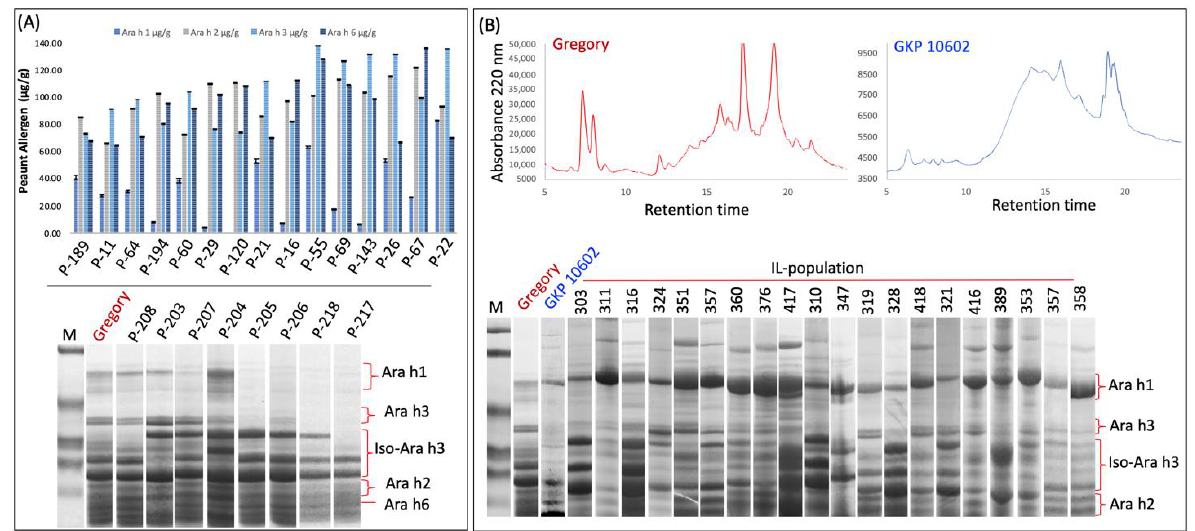
Figure 2. Protein profiles of peanut genotypes with reduced content of immunogenic proteins Ara h1, Ara h2, Ara h3, and Ara h6. Selected genotypes of the USDA and ICRISAT mini-core collections with reduced content of major immunogenic proteins studied using enzyme-linked immunosorbent assay (ELISA) ( A , top ). SDS-PAGE gel showing selected genotypes of the South Asian collection lacking Ara h1, Ara h3, and Ara h6 completely or accumulating a reduced amount of different immunogenic proteins ( A , bottom ). High-performance liquid chromatograms of seed-storage proteins extracted from peanut cultivar ‘Gregory’ and Arachis diogoi accession GKP 10602 (identified from the screen for reduced immunogenicity liens) ( B , top ). Notice the significant reduction in the HPLC peak area in GKP 10602 at corresponding elution times compared to Gregory (pay attention to the scale on the y-axis). Protein profiles of Gregory and GKP 10602 and the interspecific hybrid population derived from their genetic cross (only selected introgression lines shown). Notice the missing protein bands and the differences in the intensity of different protein bands ( B , bottom ). M = pre-stained protein marker.